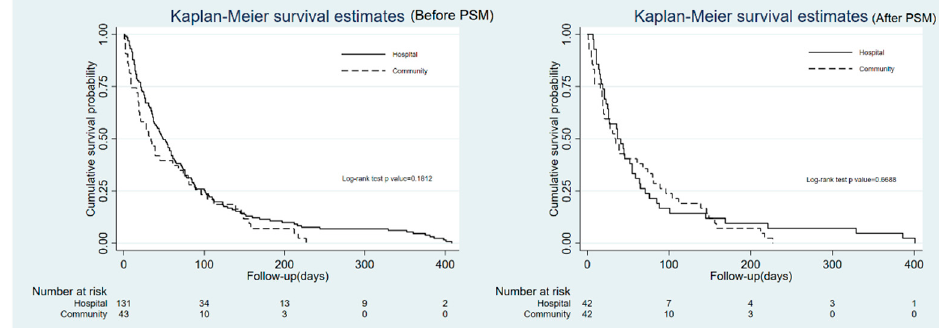
Figure 3. Comparison of the duration of survival between patients receiving hospital-based palliative care and community-based palliative home care before and after PSM.